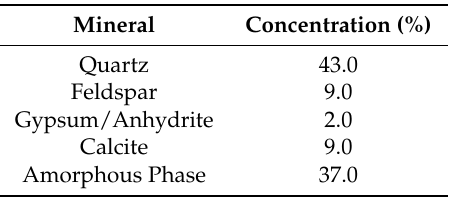
Table 1. Semi-quantitative analysis of TCC.